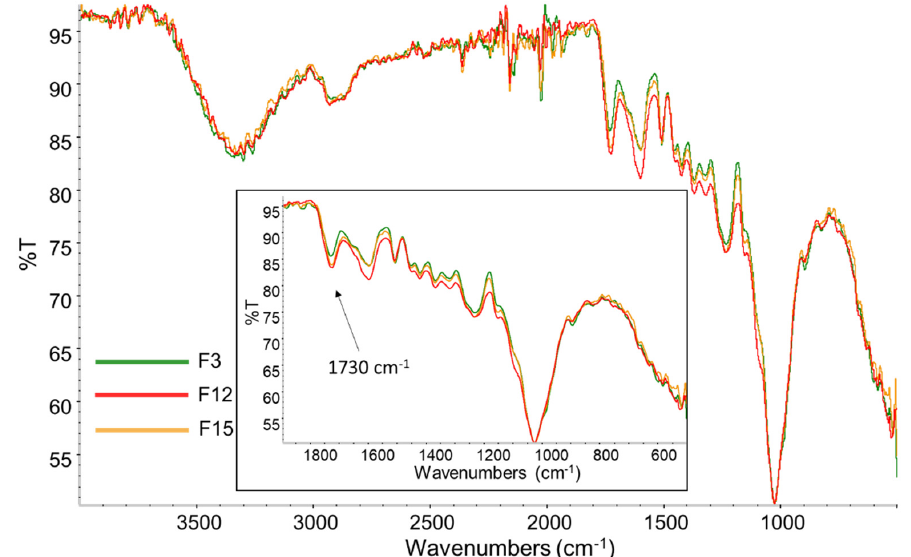
Figure 6. Comparison of the FTIR spectra of composites produced with unmodified HSP (F3) and HSP modified with MA/ESO (F12) and SA/ESO (F15). HSP modified with MA/ESO (F12) and SA/ESO